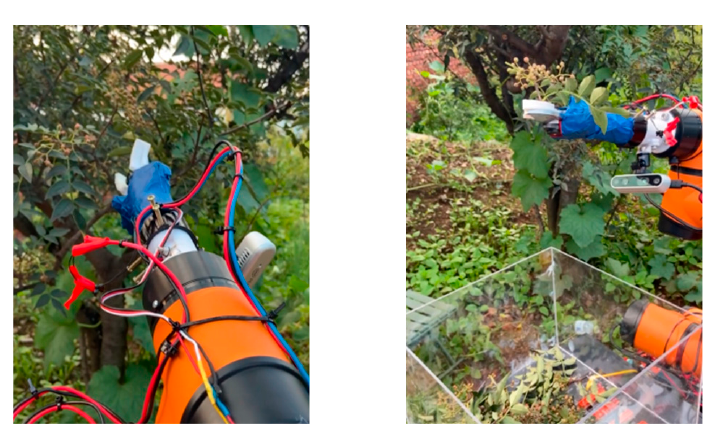
Figure 15. Prickly ash-picking robot work diagram.